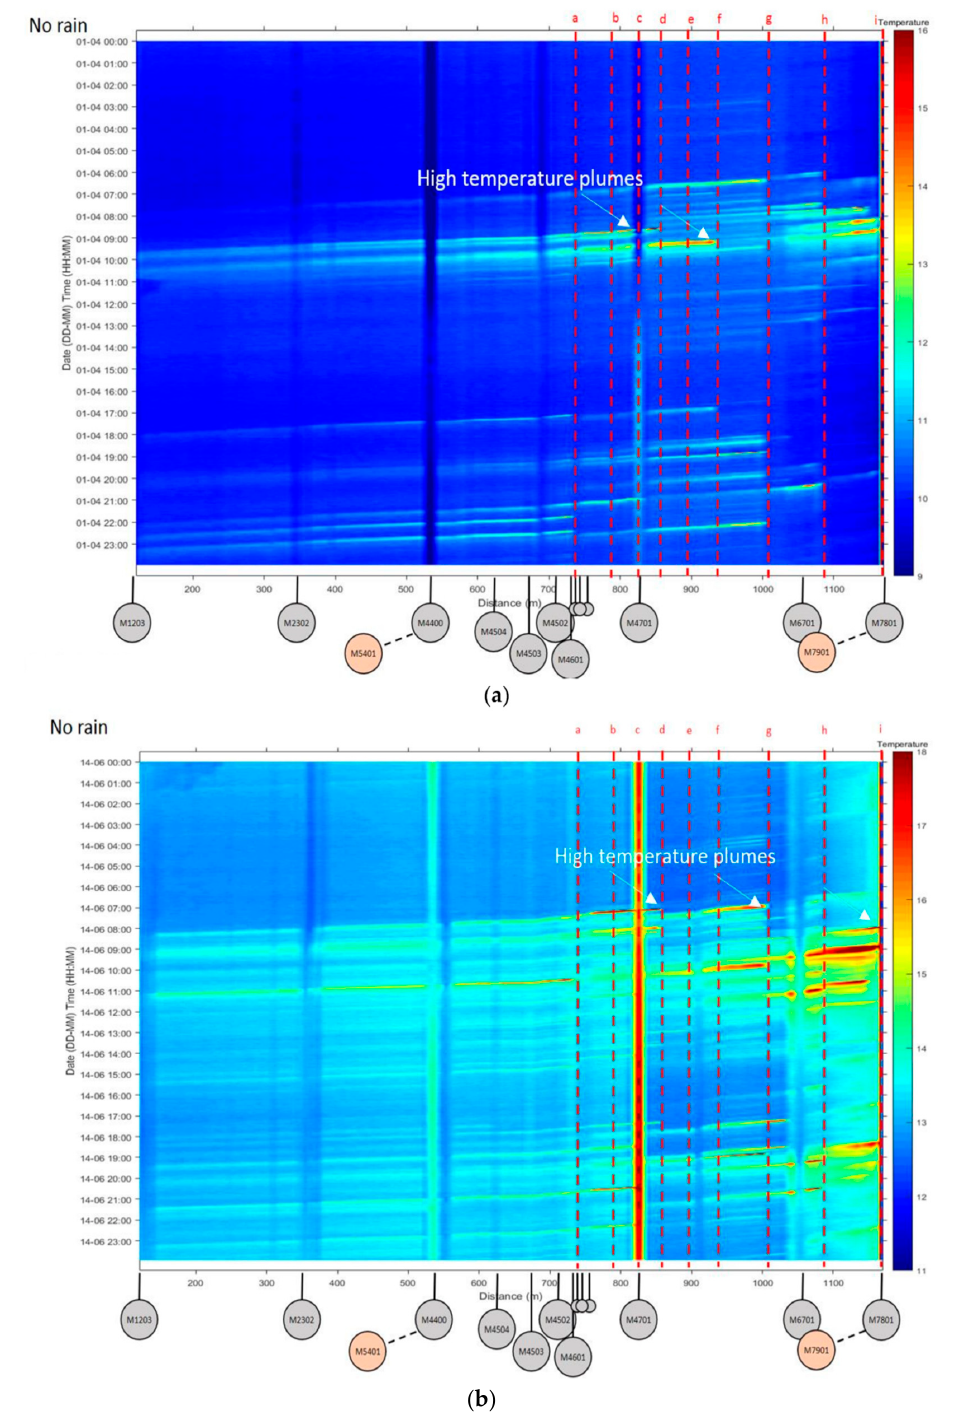
Figure 4. Distributed temperature sensing (DTS) results without rain: ( a ) 1 April; ( b ) 14 June.